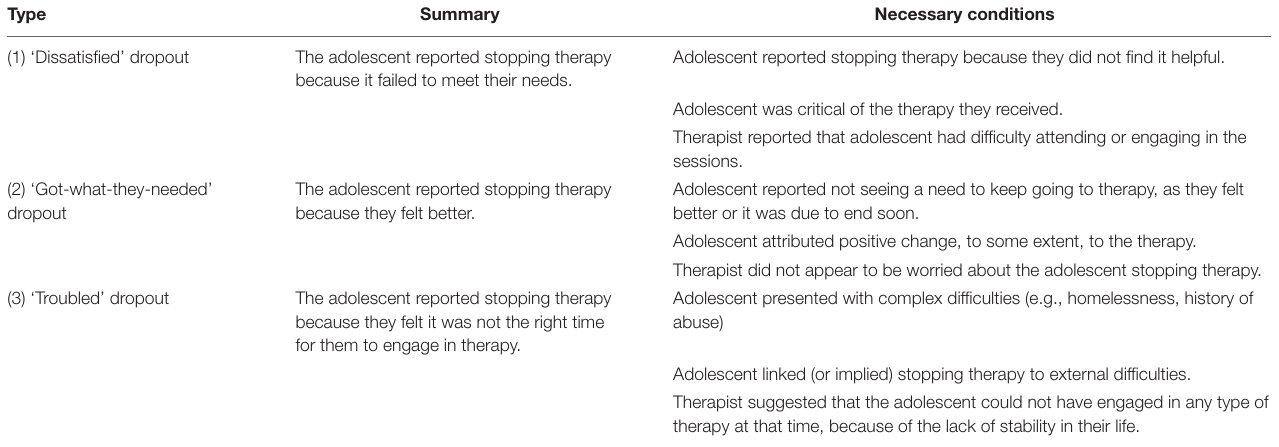
TABLE 2 | Ideal types coding